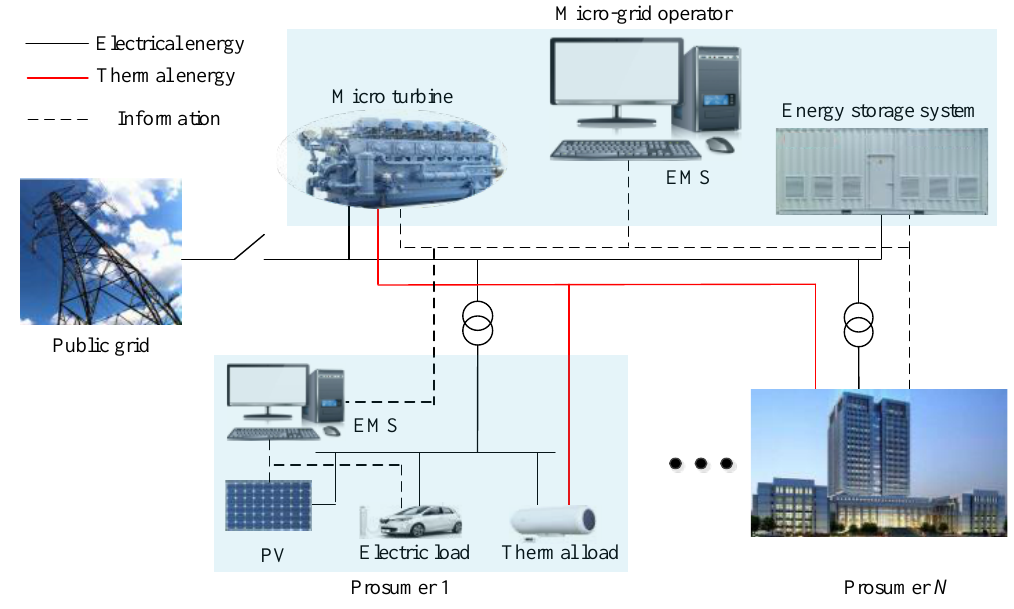
Figure 1. Structure of community energy